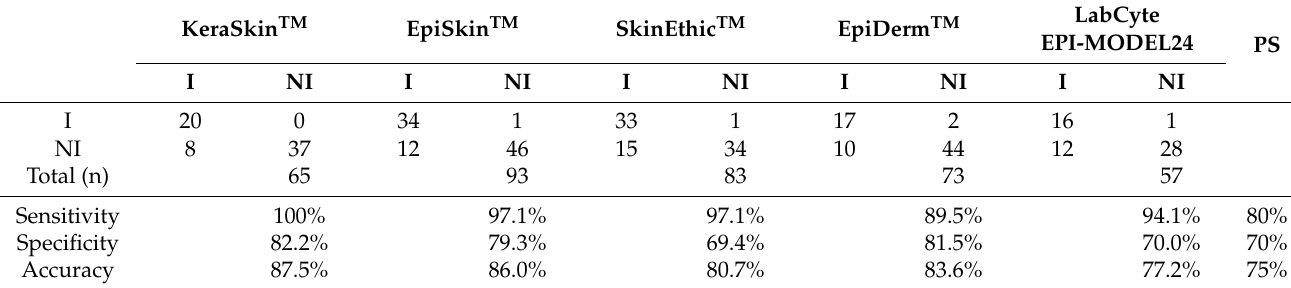
Table 3. Predictive capacity of VRM viability.